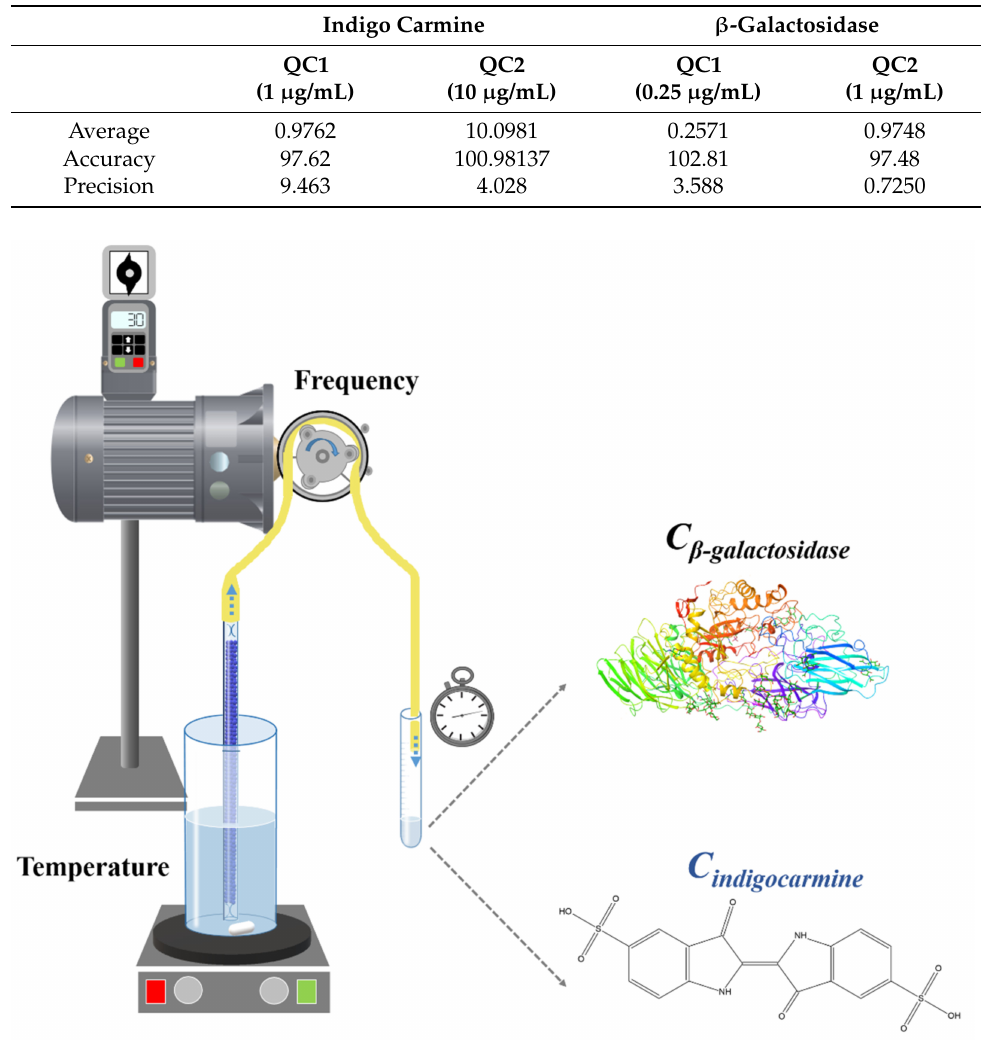
Table 1. The results of the quality control measurements.